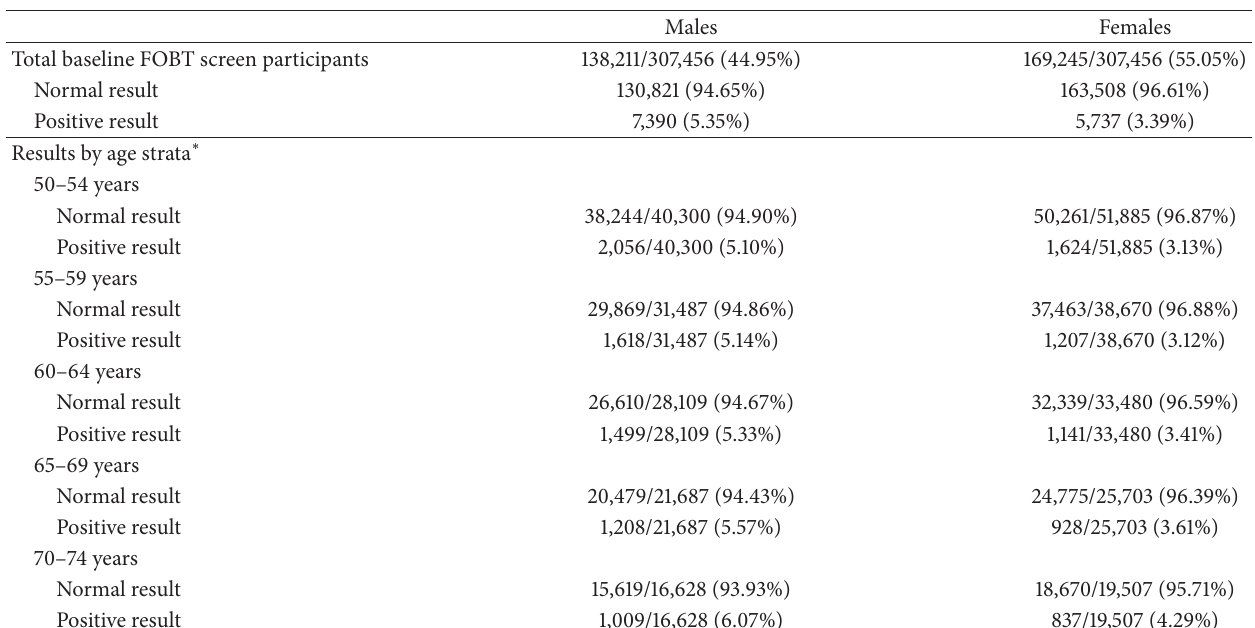
Table 1: Baseline gFOBT screen between April 2008 and December